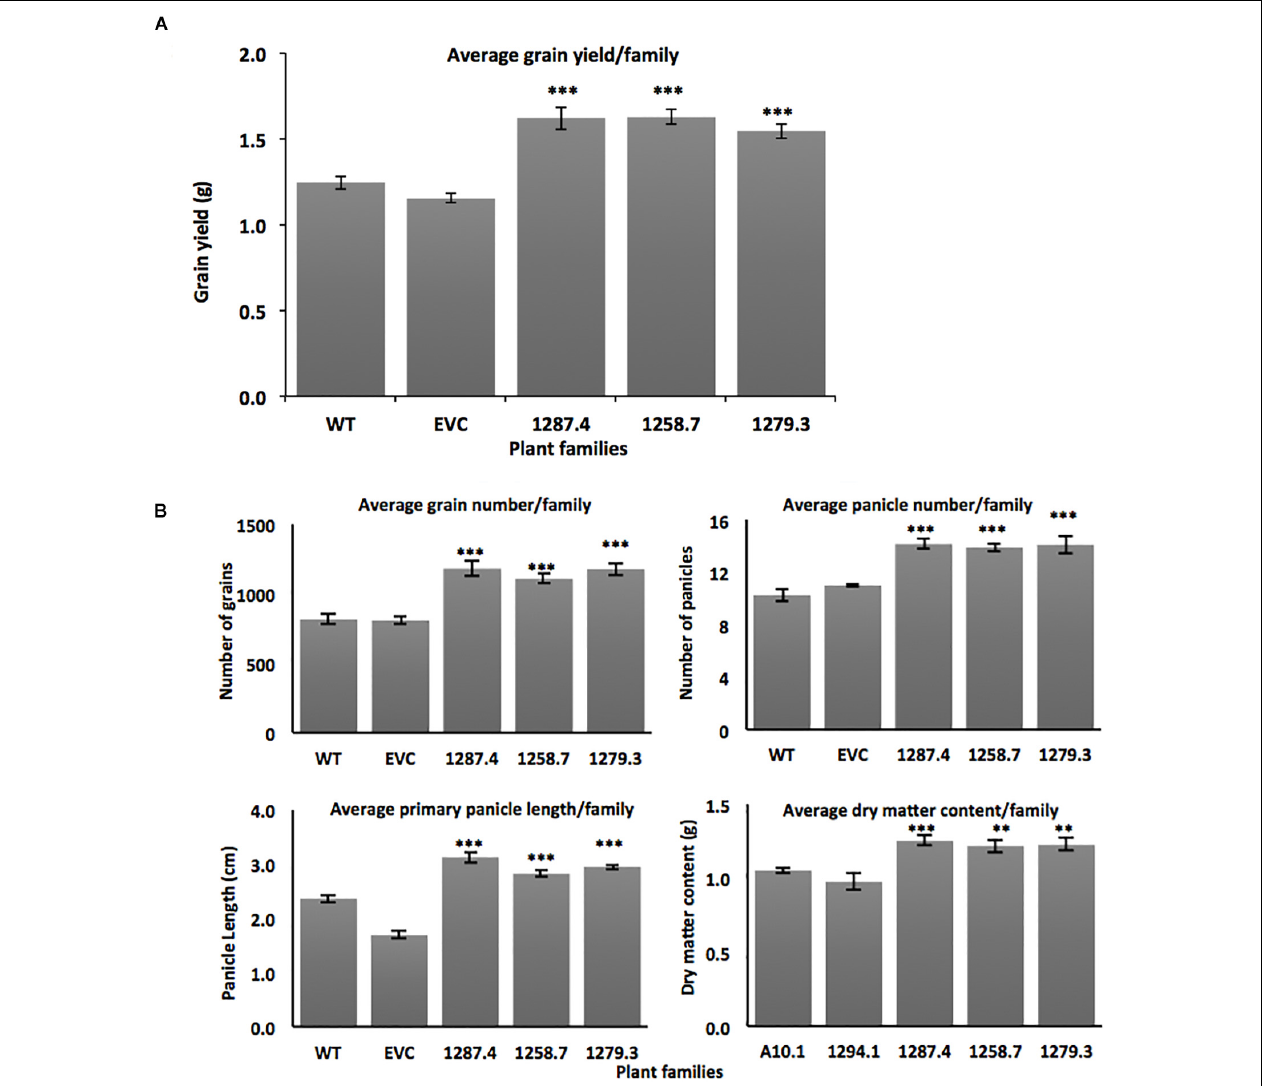
FIGURE 3 | Agronomic trait characterization of transgenic MCOAtcel1 T 3 events (A) Elevated grain yield in T 3 S. viridis families transgenic for MCOAtcel1 in comparison to controls ( n = 16 per family). (B) Elevated grain number, panicle number, primary panicle length, and vegetative dry matter content in T 3 S. viridis families MCOAtcel1 in comparison to controls ( n = 16 per family). Data are shown as mean ± SEM, with p ≤ 0.001(***)/ p ≤ 0.01(**)/ p ≤ 0.05(*). EVC (empty vector control) and WT (wild type